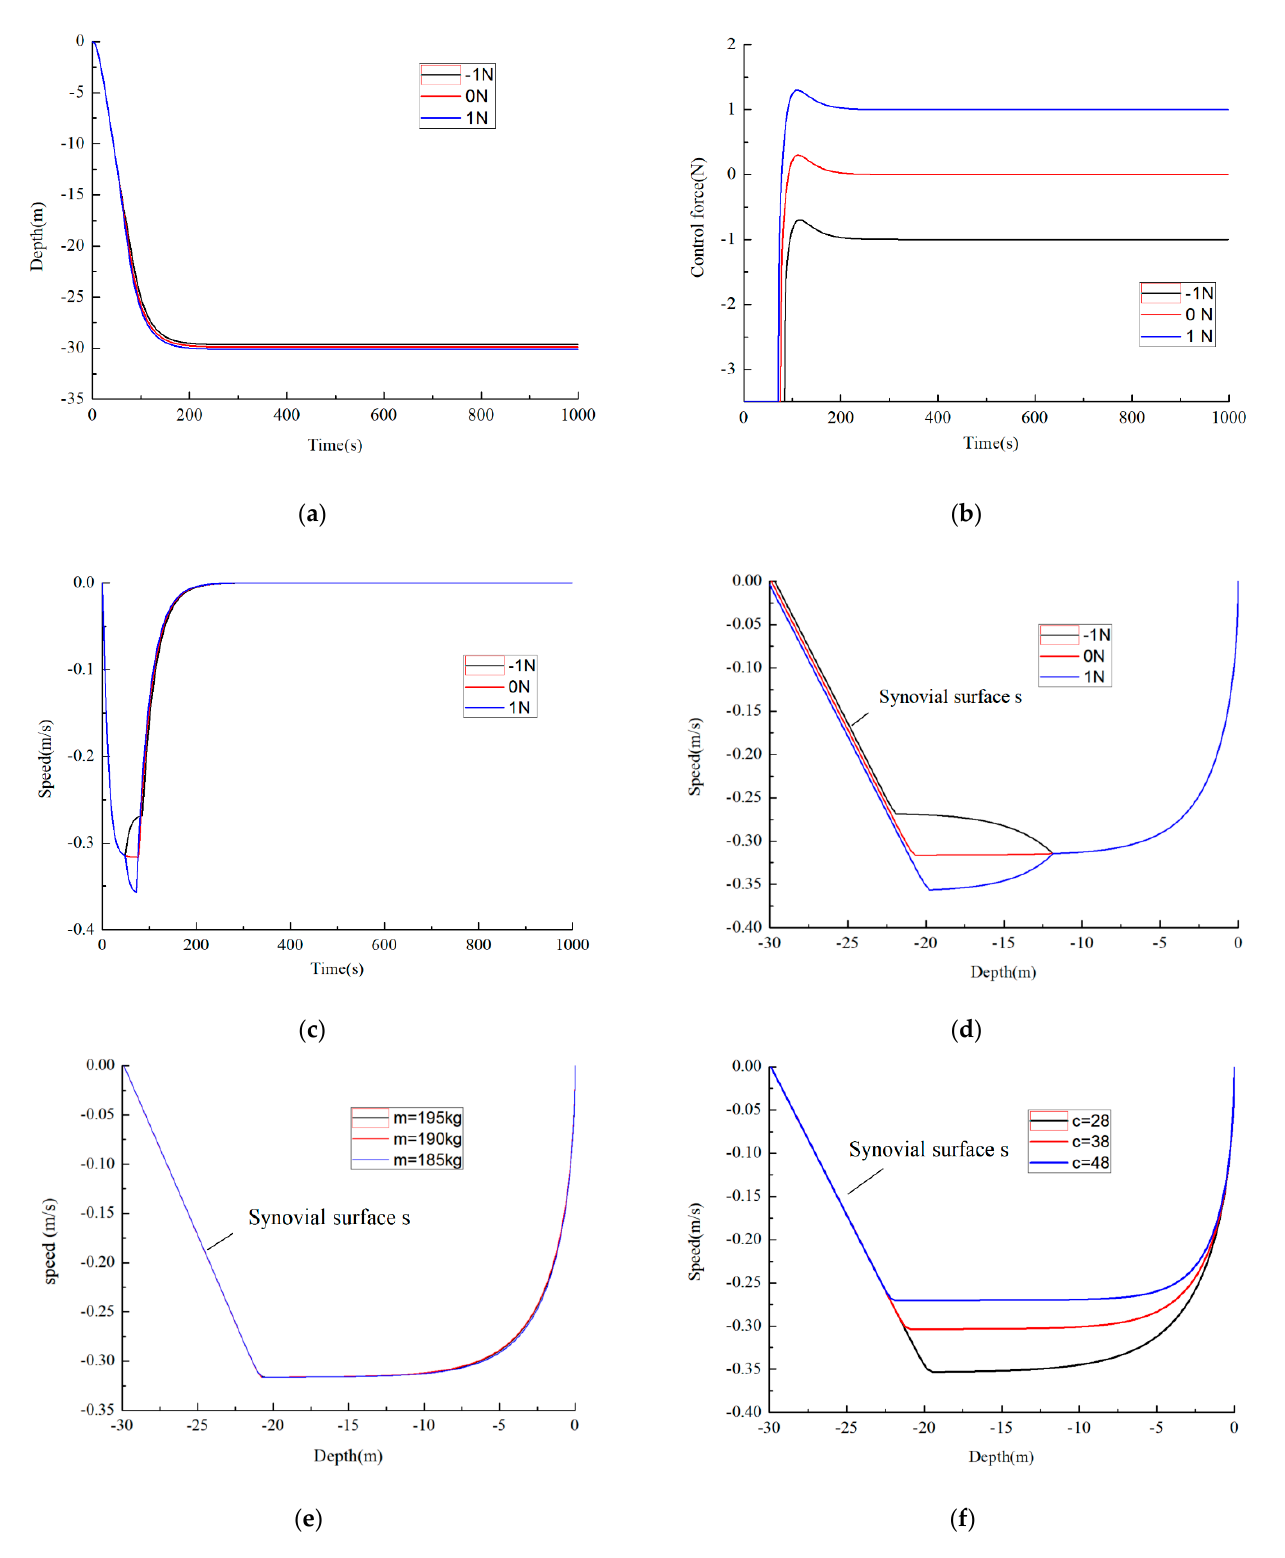
Figure 3. Simulation curves of the sliding mode control. ( a ) Depth curves at different external forces. ( b ) Control force curves at different external forces. ( c ) Speed curves at different external forces. ( d ) Trajectory − tracking phase diagram at different external forces. ( e ) Trajectory − tracking phase diagram at different mass. ( f ) Phase diagram at different damping coefficients The simulation curve of the conventional PID depth controller is shown in Figure 4.